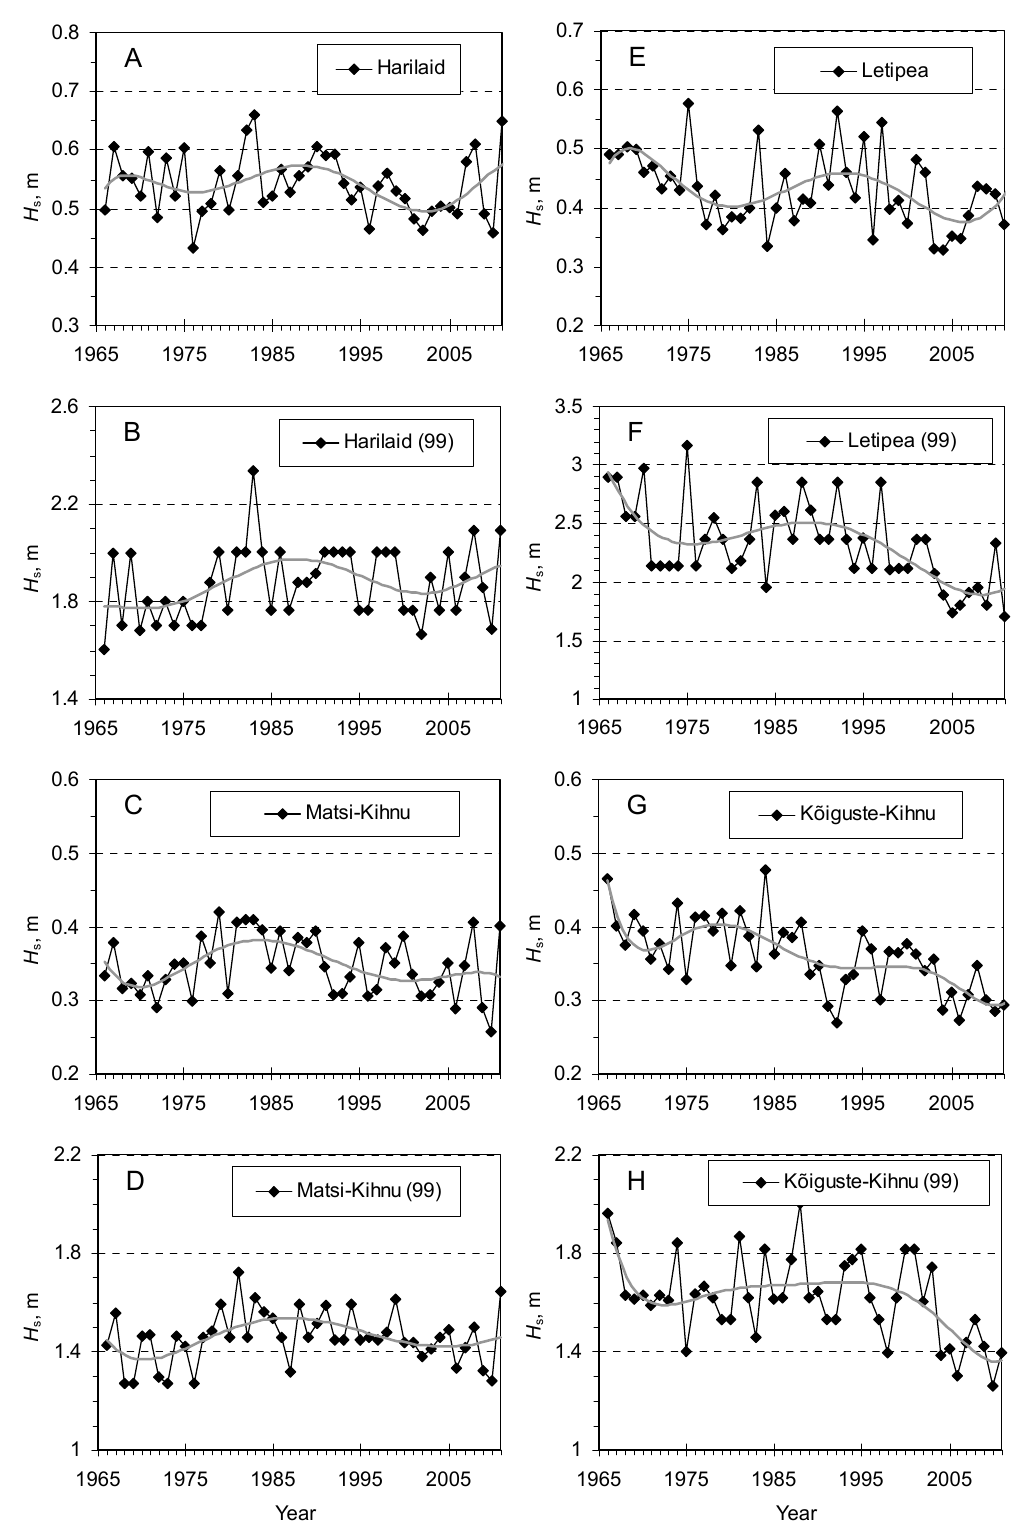
Fig. 6. Annual average (A, C, E, G) and 99%-ile (B, D, F, H) wave height at four modelling locations in 1966(cid:150)2011. Matsi and Kıiguste time series are calculated using Kihnu winds. Sixth-order polynomial trendlines are added for visualization of quasi- cyclicity; for statistics according to linear trendlines see Table